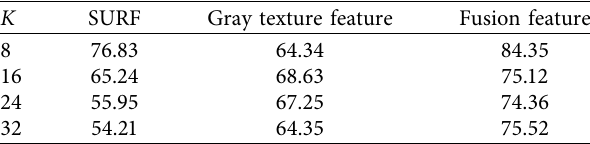
Table 2: Comparison of precision rates of several feature extraction